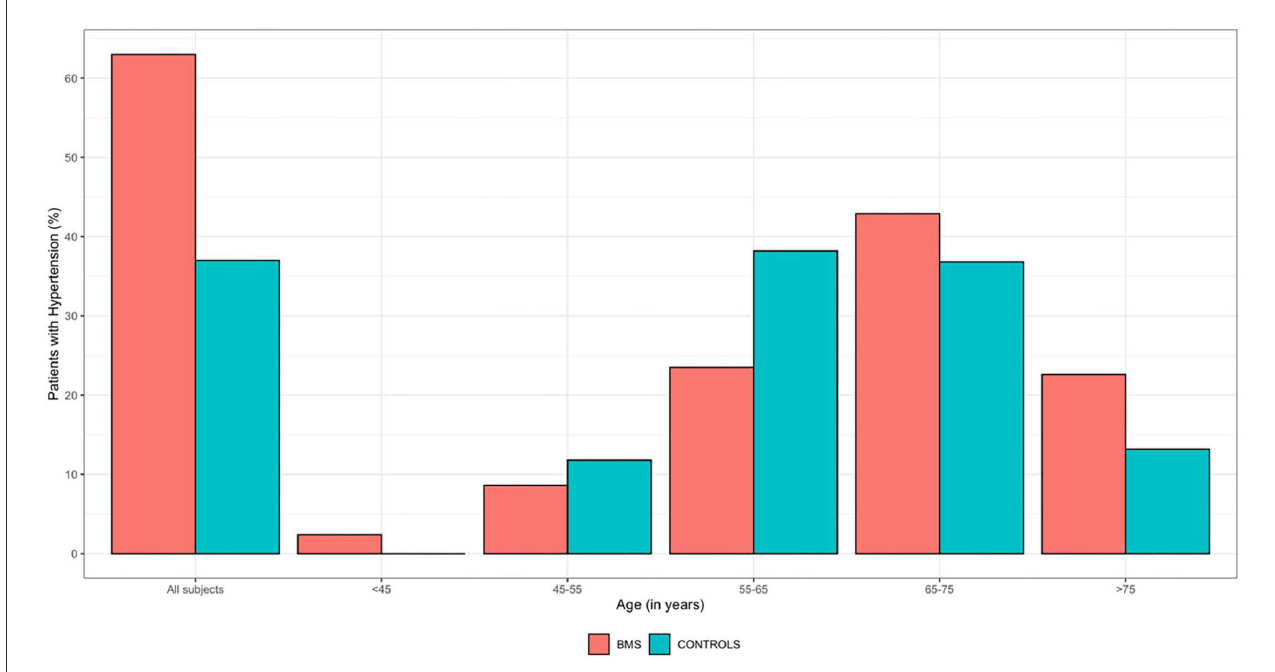
FIGURE2 Frequency distribution of HTN by age ranges of 250 WBMS and 250 HW. HW, healthy women; WBMS, women with BMS.